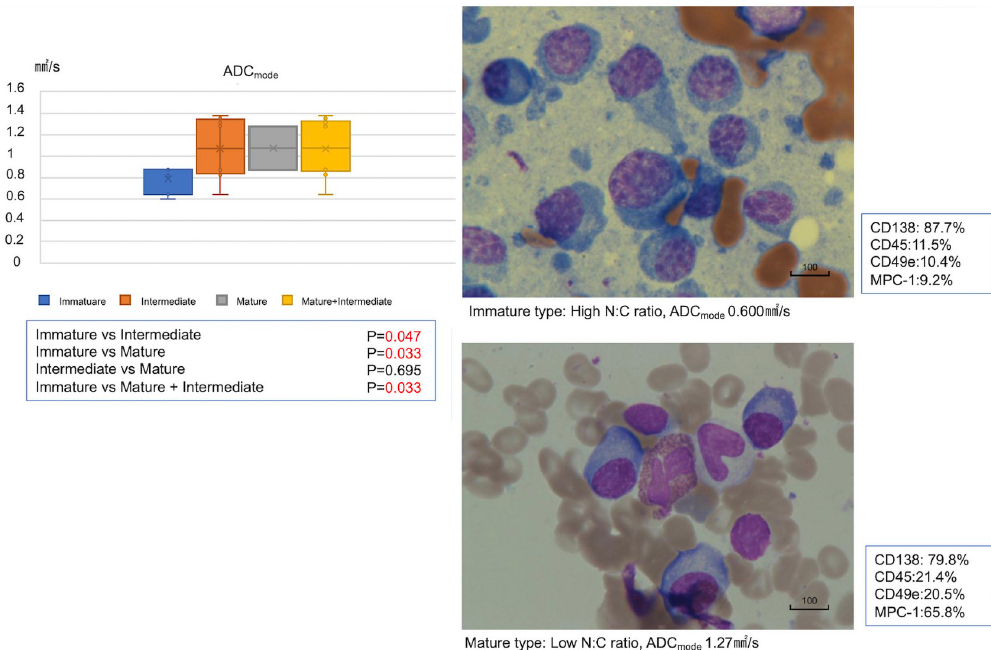
Fig 3. Myeloma cell morphology and apparent diffusion coefficient (ADC) values. The ADC mode was 1.10 ± 0.26 × 10 − 3 mm 2 /s in the mature myeloma cell type, 0.99 ± 0.40 × 10 − 3 mm 2 /s in the intermediate myeloma cell type, and 0.82 ± 0.17 × 10 − 3 mm 2 /s in the immature myeloma cell type. ADC values of the intermediate and mature cell types were significantly higher than those of the immature cell type. N:C ratio, nucleus-to-cytoplasm ratio.